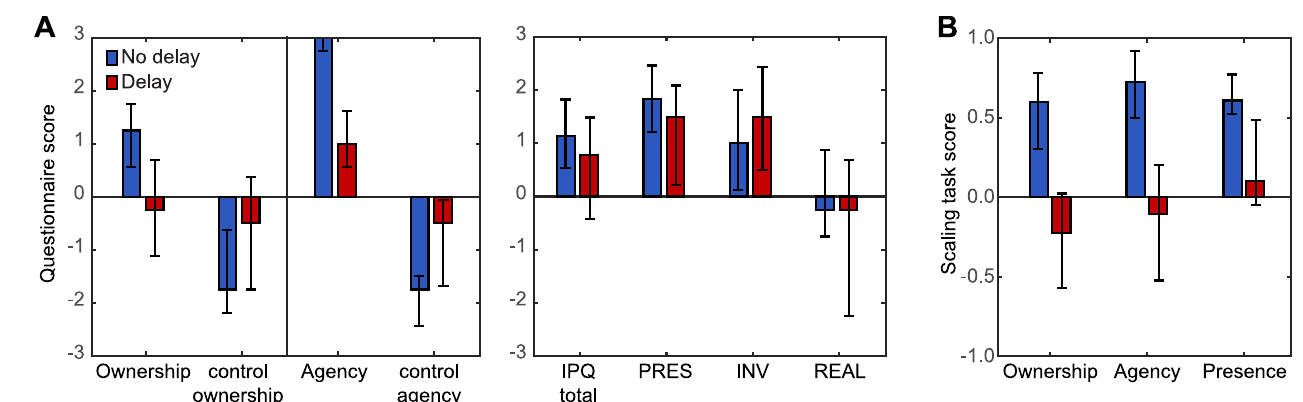
Fig 2. Questionnaire and scaling task results. (A) shows the results of the established ownership and agency as well as the IPQ questionnaires. The left panel shows the results from the ownership and agency questionnaire [12] the right panel shows the results from the IPQ [29]. IPQ results are shown as a total score and along the Presence (PRES), Involvement (INV) and Realism (REAL) subscales. (B) shows the median results for the scaling task. Blue bars represent the No-Delay condition, red bars the Delay condition. Bars represent medians and error bars represent the interquartile ranges across participants. The results confirm previous findings that an added feedback delay on the observer’s movement has detrimental effects on the subjective ratings for ownership, agency and presence.